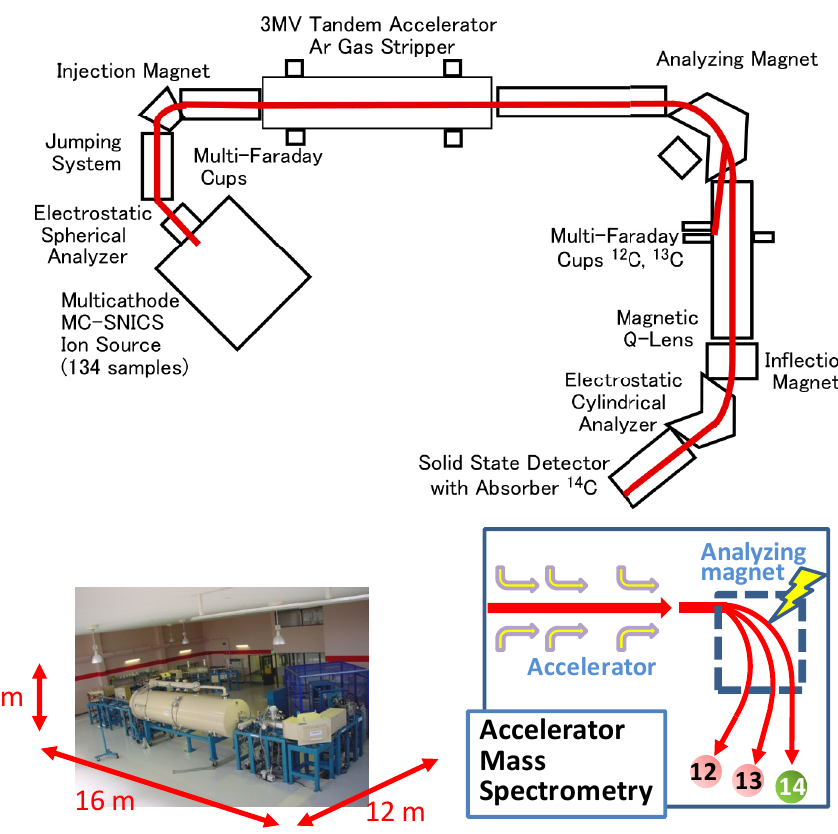
Figure 7. Outline of AMS